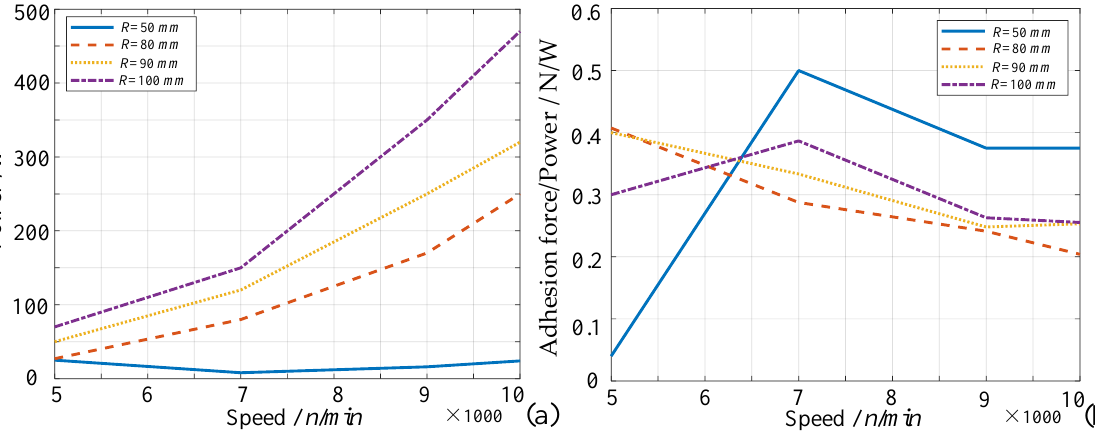
Figure 10. Simulation analysis of power consumption. ( a ) Results of required power when impeller height ℎ = 10 mm. ( b ) The efficiency when impeller radius ℎ = 10 mm.